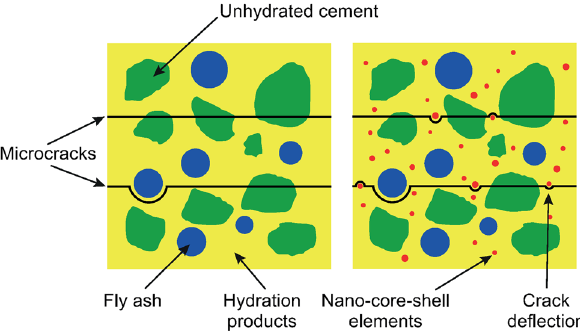
Figure 10: E ff ect of nano - titanium dioxide on fracture develop - ment [ 113 ]